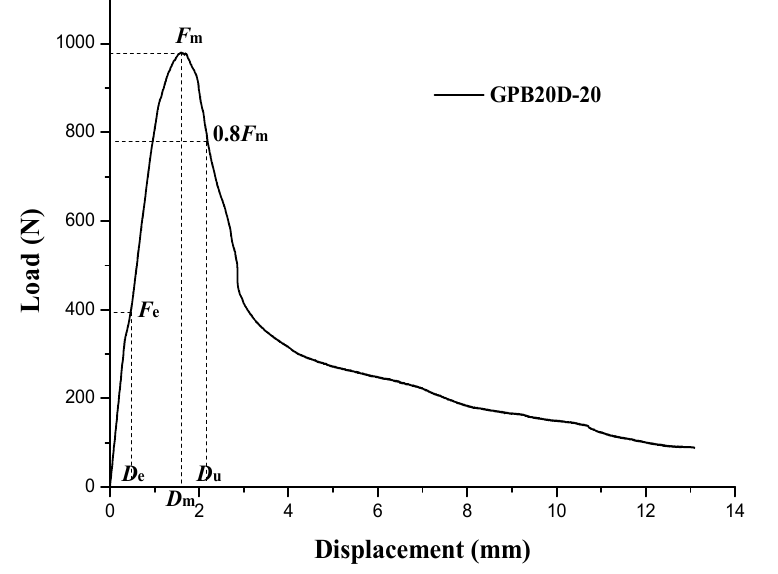
Figure 5. Typical load–displacement curve of (gypsum plasterboard) GPB20D ‐ 20.